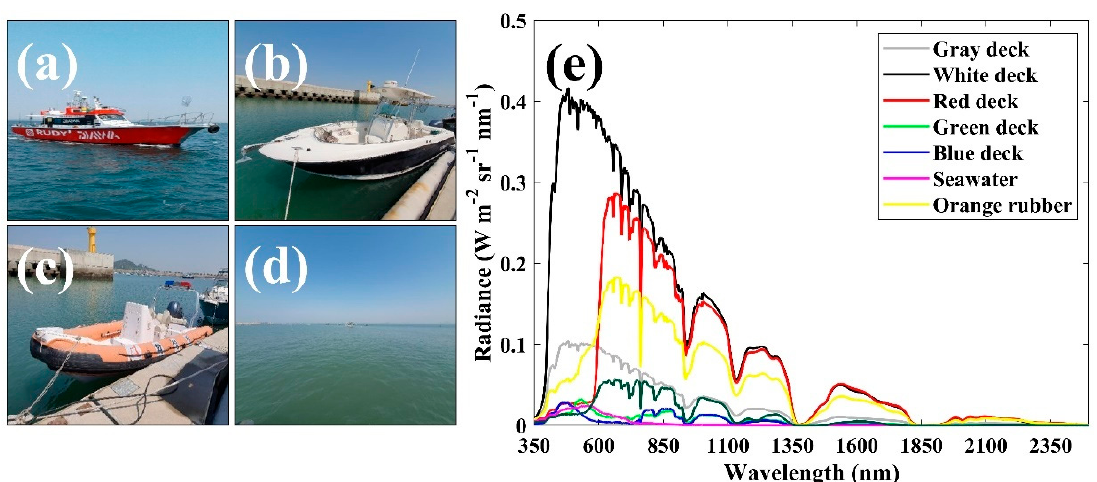
Figure 3. ( a ) Fishing boat, ( b ) yacht, ( c ) lift boat, ( d ) seawater, and ( e ) spectral radiance of the decks of vessels and seawater as a function of wavelength.